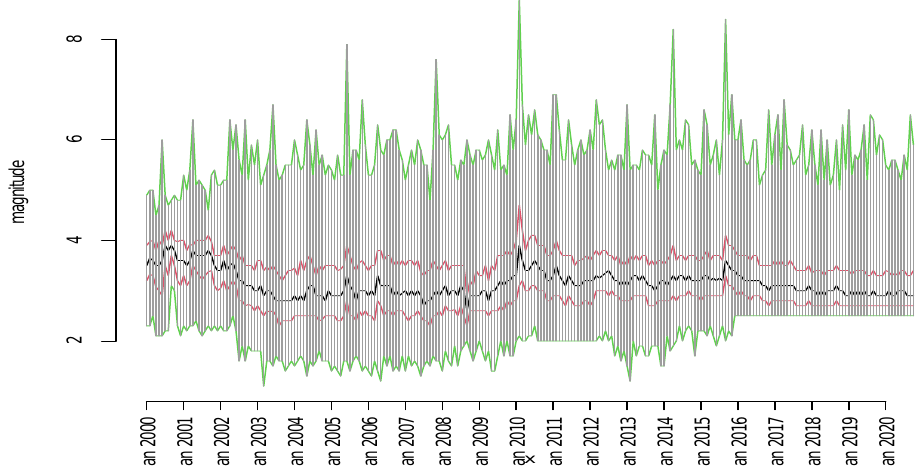
Figure 2. Magnitude distribution by month; the green lines are the monthly minima and maxima, the red lines are the first and third monthly quartiles, while the black line is the monthly median. In addition, the considered areas include the major earthquakes of the last 30